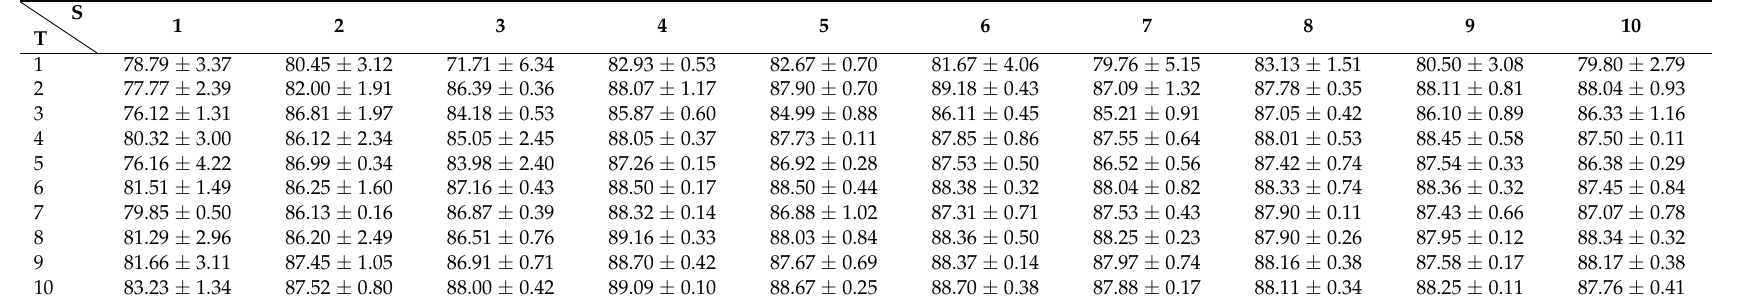
Table 3. Means and deviations of test accuracy with different combinations of S and